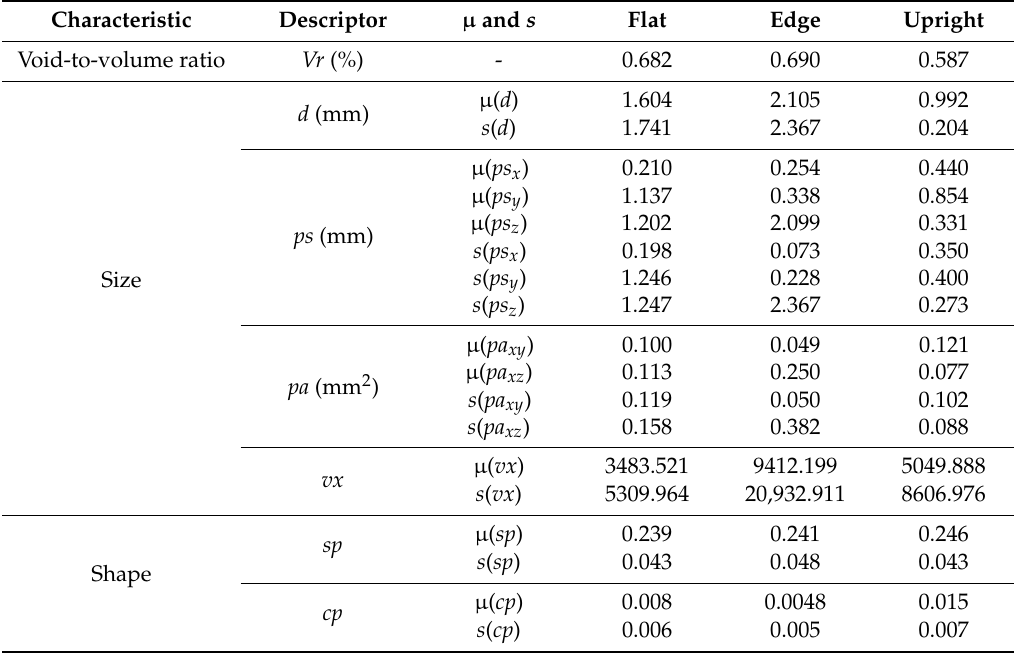
Table 1. Defect detection mean ( µ ) and standard deviation ( s ) of void characteristics for tensile samples.